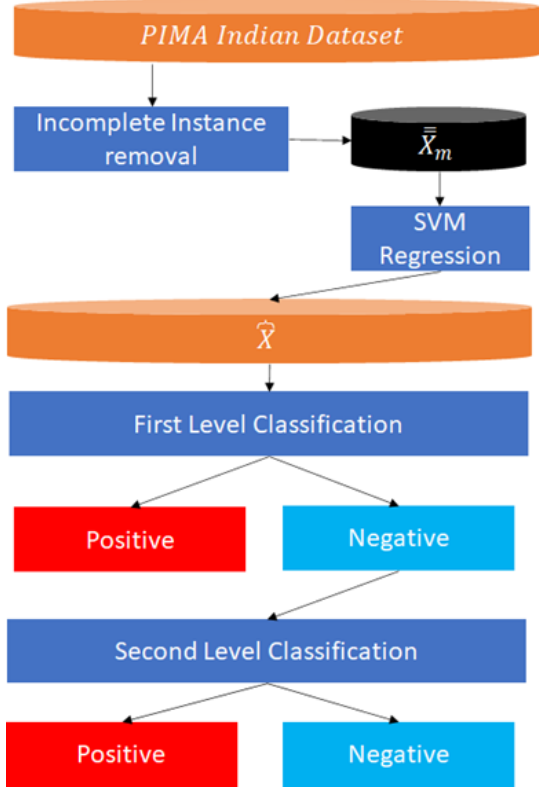
Figure 1. Workflow of the proposed